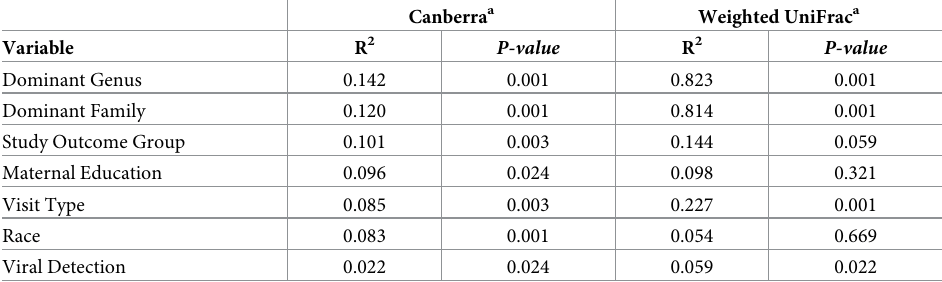
Table 3. Environmental, clinical, viral, and microbiological factors are associated with variance in bacterial com- munity composition using a bootstrapped approach for repeated